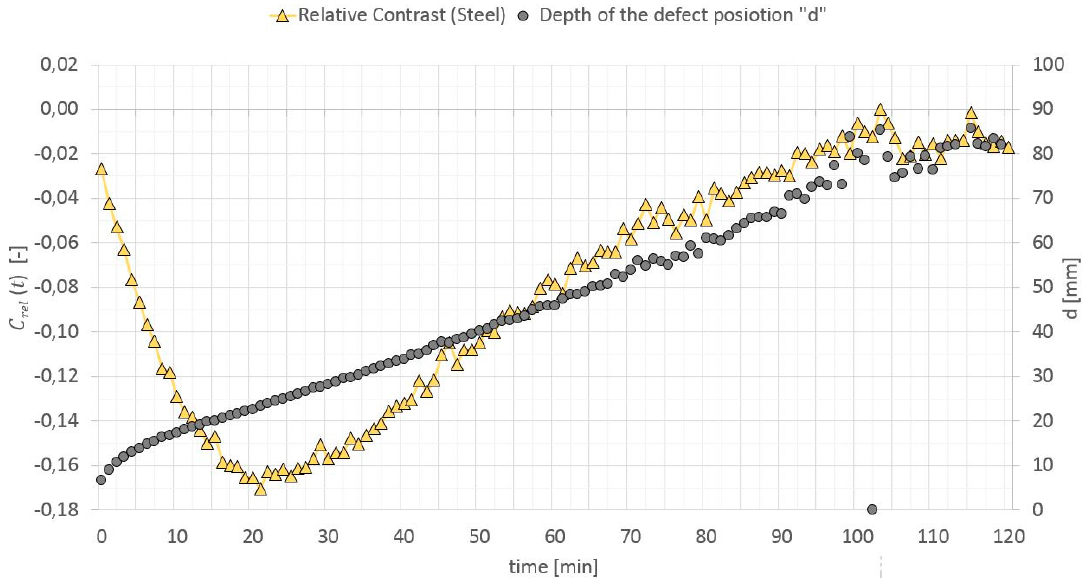
Figure 20. Relative contrast and defect location depth versus time (Steel).